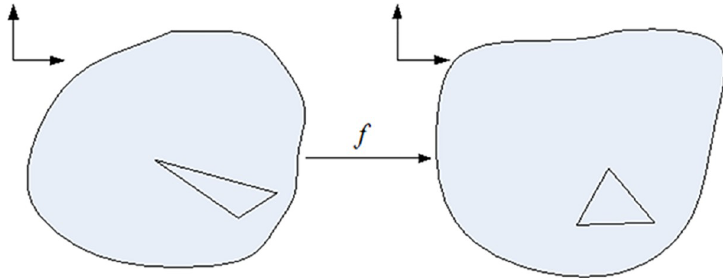
Fig 6. Illustration of boundary-free quasi-harmonic